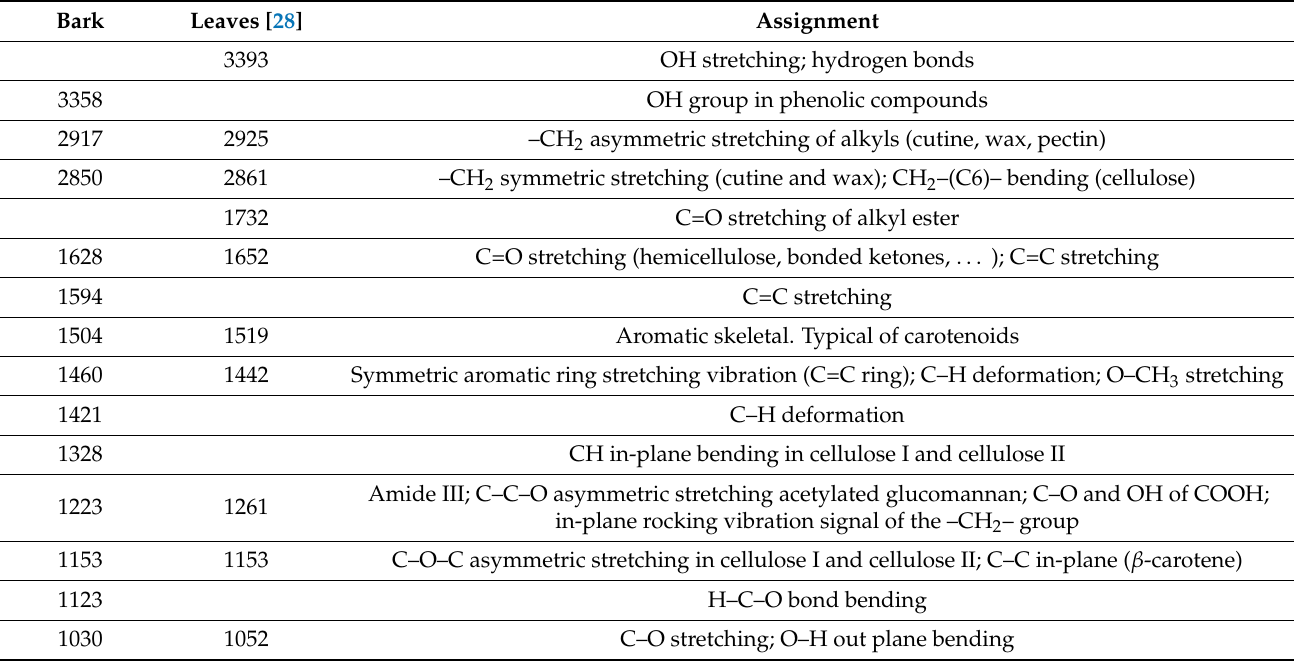
Table 1. Main bands in the infrared spectra of T. gallica bark and leaves.